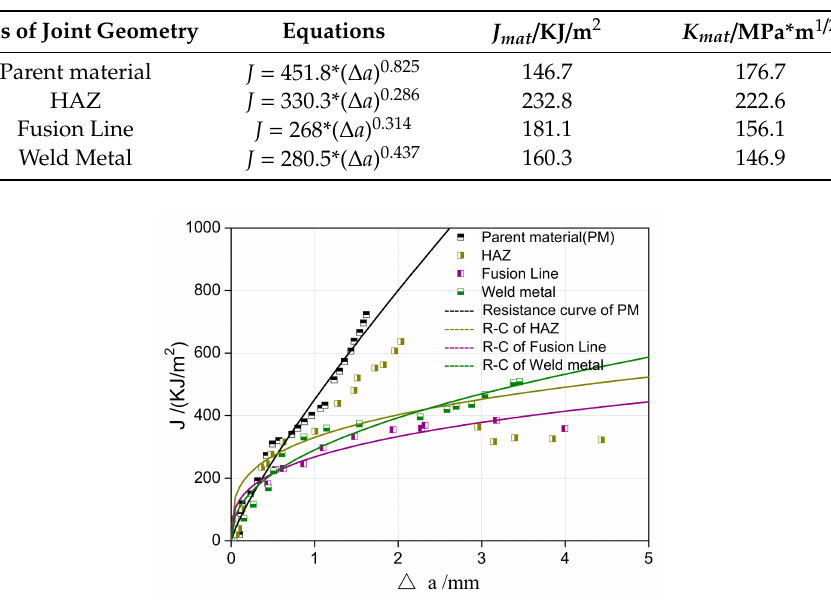
Table 8. The resistance equations and the J mat and K mat value of the undermatched welded joint.